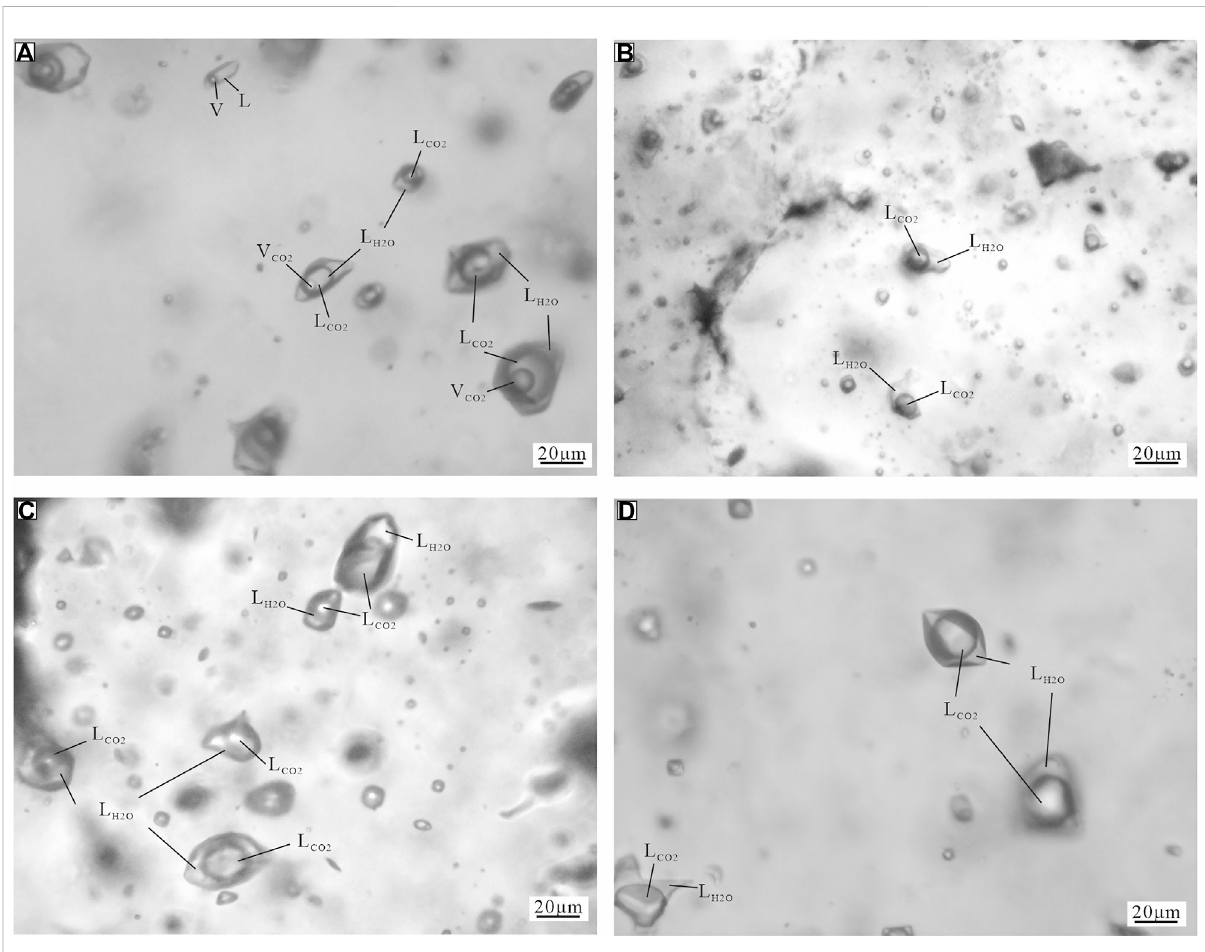
FIGURE 6 Fluid inclusions in the Dongtongyu gold deposit. (A) -Some L-V fl uid inclusions coexist with H 2 O-CO 2 inclusions (L H2O -L CO2 and L H2O -L CO2 - V CO2 )inaquartzvein(Q2); (B) -L H2O -V CO2 andL H2O -L CO2 -V CO2 inclusions(someweredecrepitated)inaquartzvein(Q2); (C) -L H2O -L CO2 inclusionsin a quartz vein (Q2); (D) -L H2O -L CO2 fl uid inclusions in a quartz vein